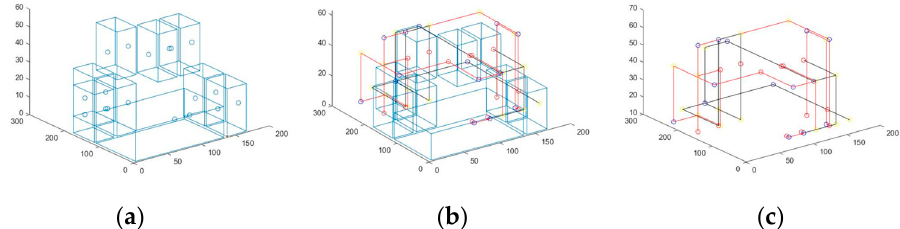
Figure 10. ( a ) The randomly generated layouts; ( b ) the routing results of our routing algorithm; ( c ) the final result of the bus connection.